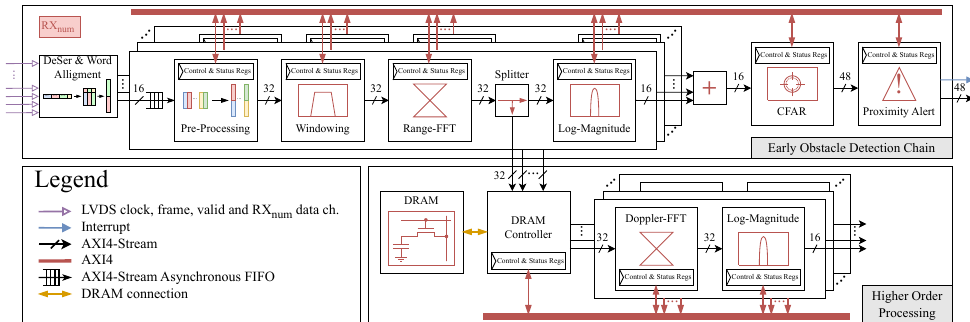
Figure 5. Block diagram of the proposed radar signal processing architecture for early detection of automotive obstacles. Clock domain crossing (CDC) is realized as asynchronous AXI4-Stream FIFOs. PLL generating different clocks is omitted from the block diagram. The number of data channels RX num is